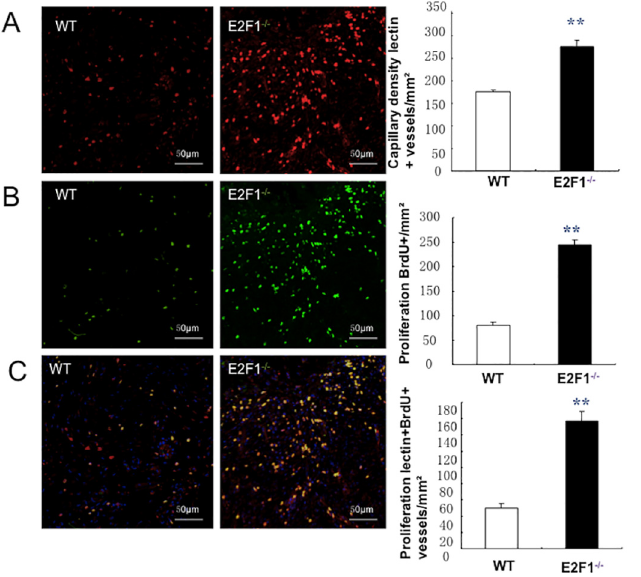
Fig 3. E2F1-deficiency enhances vessel growth in the border area of the skin wound. At day 7 post- surgery, Lectin was i.v. injected 10 min before euthanasia to identify vasculature; subsequent analyses were performed in sections of wound skin and quantified at the border zone of wounds. (A) Functional vessels were identified by staining with anti-lectin antibodies (red) ( left and middle panels , scale bar = 50mm) and quantified ( right panel ). (B) Proliferation cells were identified by staining for BrdU (green) ( left and middle panels ) and quantified ( right panel ). (C) Proliferating ECs (yellow) were identified by co-staining for BrdU (green) and lectin (red) ( left and middle panels , scale bar = 50 mm) and quantified as the number of lectin+BrdU+ vessels per mm 2 ( right panel ); nuclei were stained with DAPI (blue). ** p < 0.01; n = 10 per group.